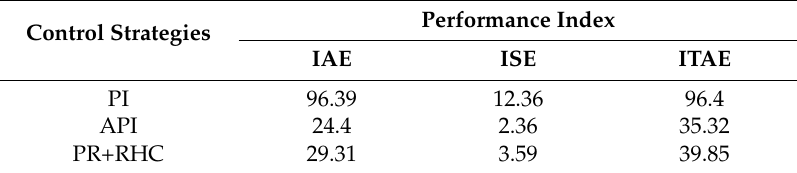
Table 14. Performance evaluation of the designed control strategies for V dc .